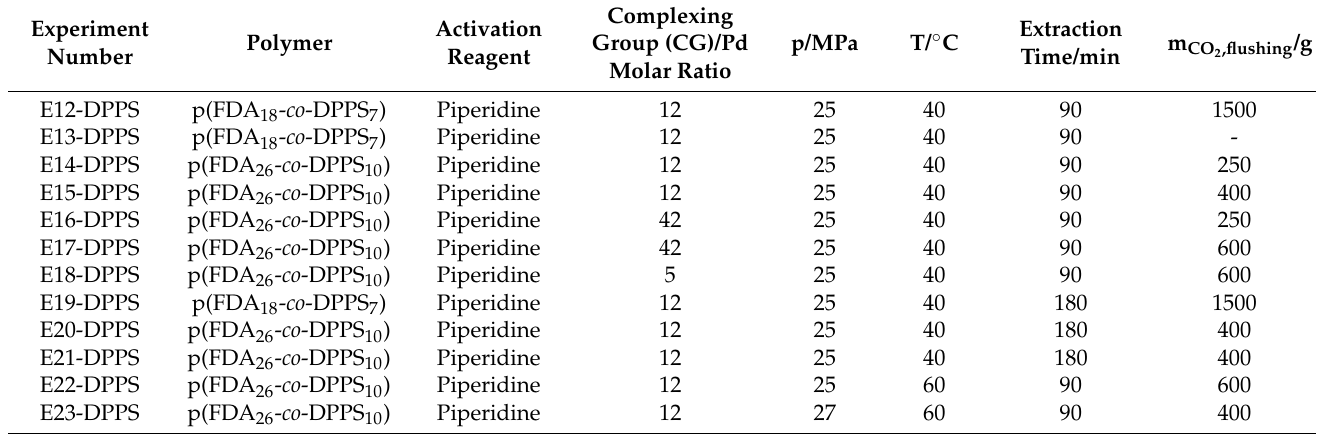
Table 5. Extraction parameters for extractions performed with polymer p(FDA- co -DPPS) at different CG/Pd ratios, extraction times and temperatures (Ex-DPPS: Detailed investigation experiments).